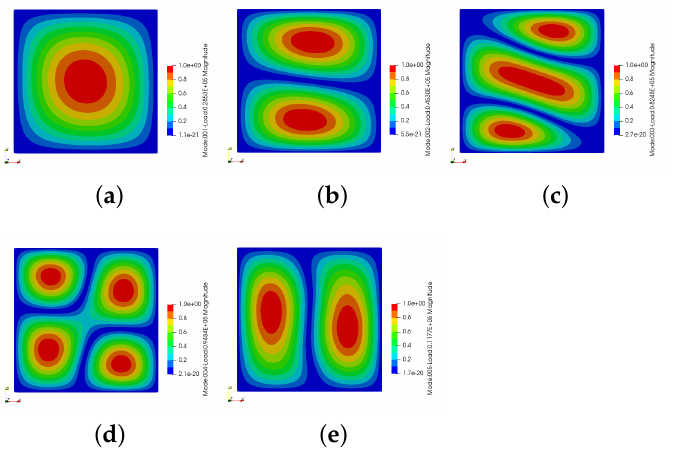
Figure 10. The first five buckling modes of optimum VAT laminates. ( a ) Mode 1: 17.38 kN. ( b ) Mode 2: 27.38 kN. ( c ) Mode 3: 49.77 kN. ( d ) Mode 4: 57.36 kN. ( e ) Mode 5: 71.72